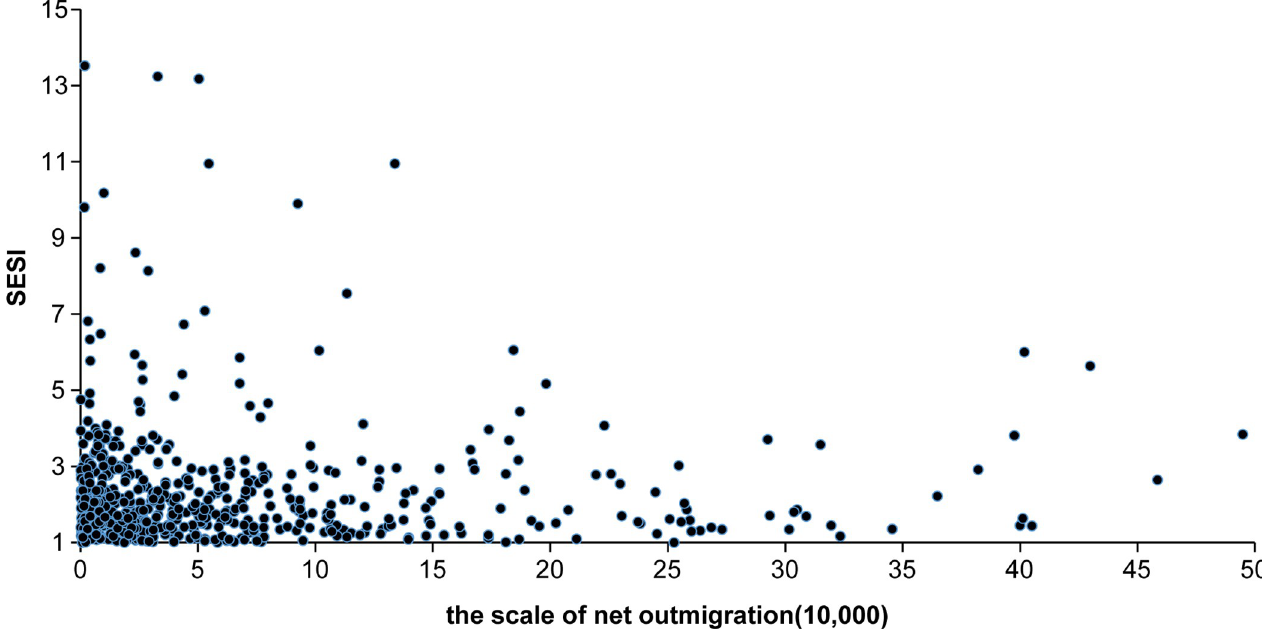
Fig 5. Scatterplot of the scale of net outmigration versus the soil erosion severity index (SESI) of counties with both.